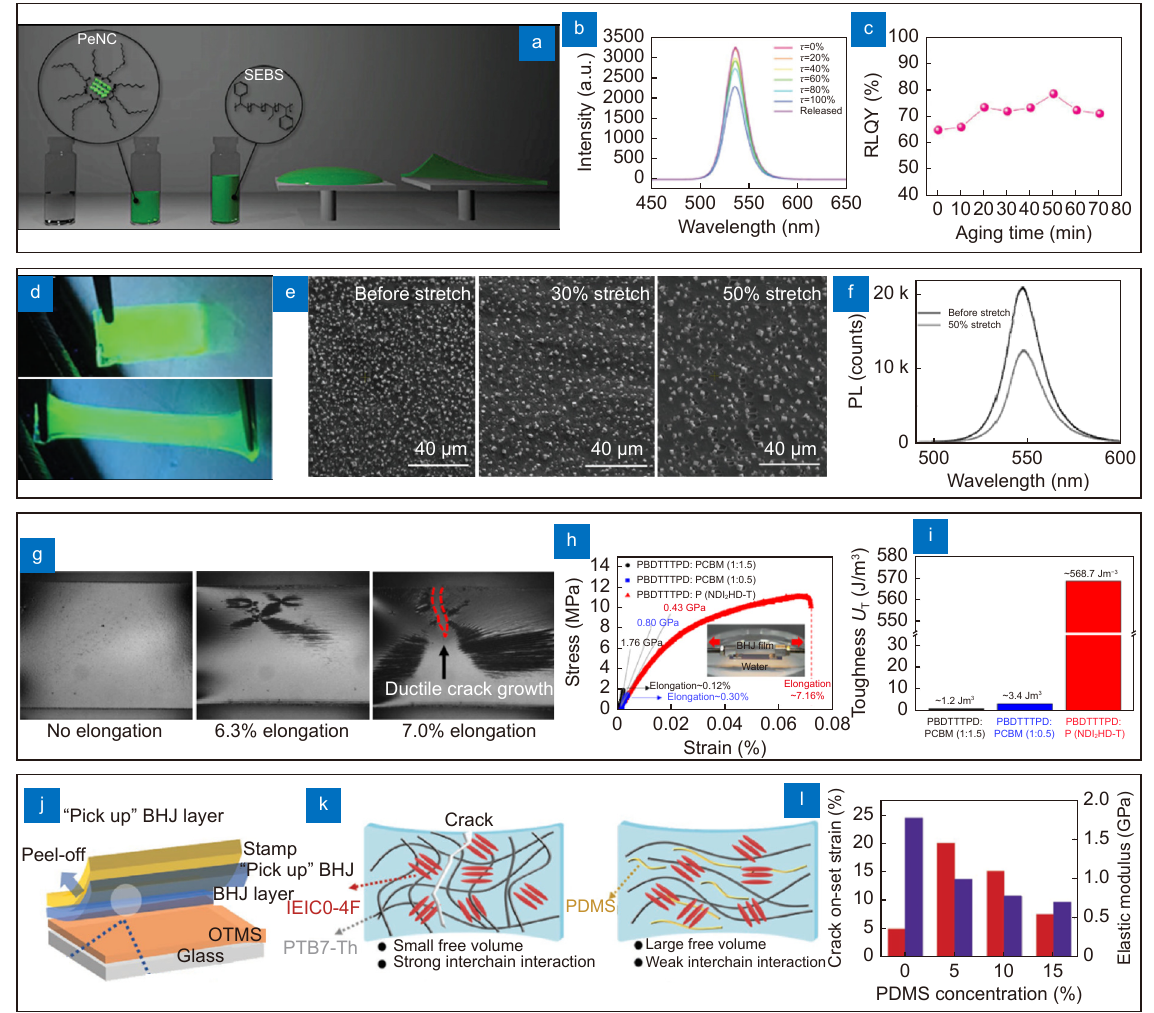
Fig. 5 | Optically active materials with intrinsic stretchability. ( a ) PeNCs mixed in SEBS and its ( b ) PL intensity and ( c ) PL quantum yield with respect to various applied strains. ( d ) Intrinsically stretchable emitting layer based on perovskite microcrystals in PEO. ( e ) SEM images of the lay- er before and during stretching with different strains. ( f ) PL intensity of the layer before and during stretching with 50% strain. ( g ) Photo-absorb- ing blended film of PBDTTTPD:P(NDI2HD-T) with intrinsic stretchability. ( h ) Stress-strain curve showing the elastic modulus and ( i ) toughness measurement results of the blend film. ( j ) Schematic of photo-absorbing layer fabrication based on mixture of PTB7-Th, IEICO-4F, and PDMS. ( k ) Schematic showing the role of PDMS for intrinsic stretchability. ( l ) The crack onset strain and elastic modulus of the film with respect to differ- ent PDMS concentrations. Figure reproduced with permission from: (a–c) ref. 163 , (d–f) ref. 152 , John Wiley and Sons; (g–i) ref. 164 , under a Creative Commons Attribution 4.0 International License; (j–l) ref. 165 , John Wiley and